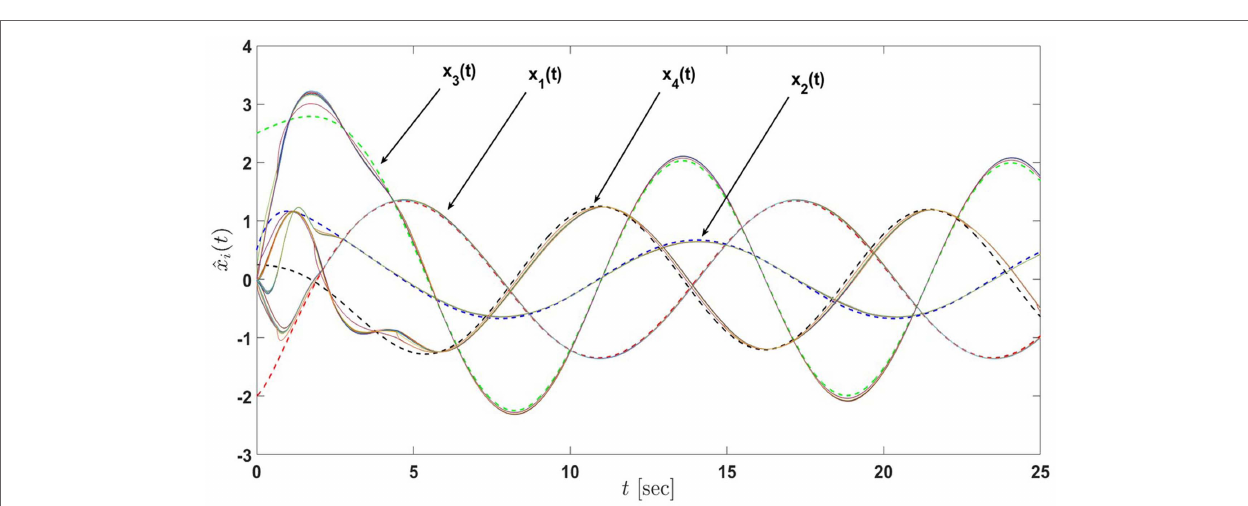
FIGURE 22 | State estimates of the active-passive sensor network in Example 5 with 13 nodes under the proposed architecture equations (58) and (59) with the decrease in (cid:27) i , i = 1, :::; 12 (the dash lines denote the states of the actual process and the solid lines denote the state estimates of nodes).